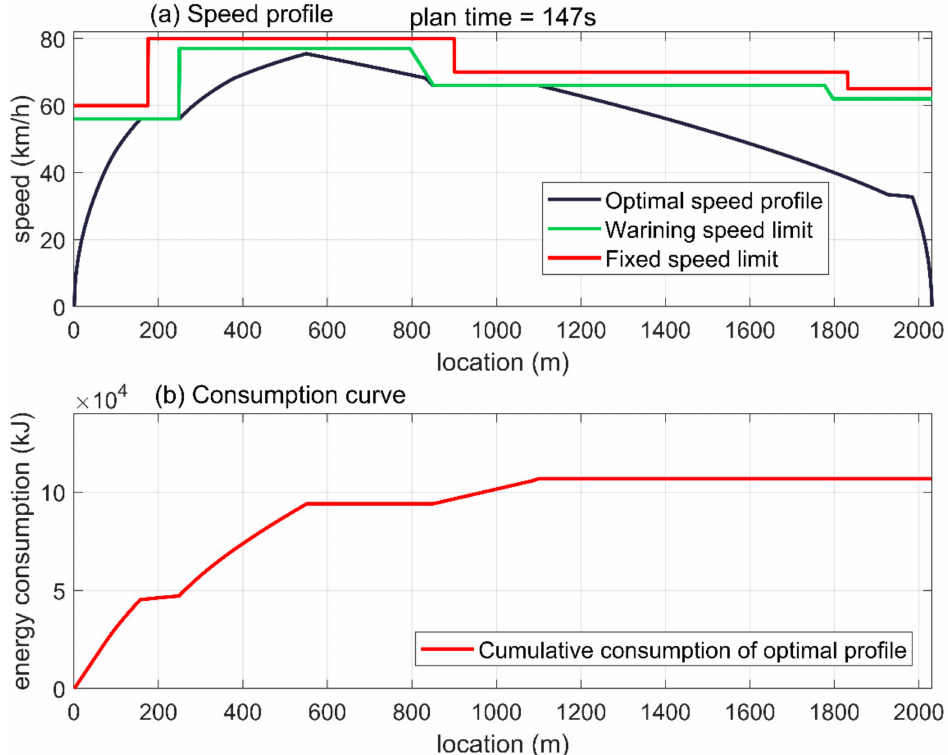
Figure 15. Optimal speed profile: ( a ) The optimal speed profile made by optimization; ( b ) Cumulative energy consumption growth